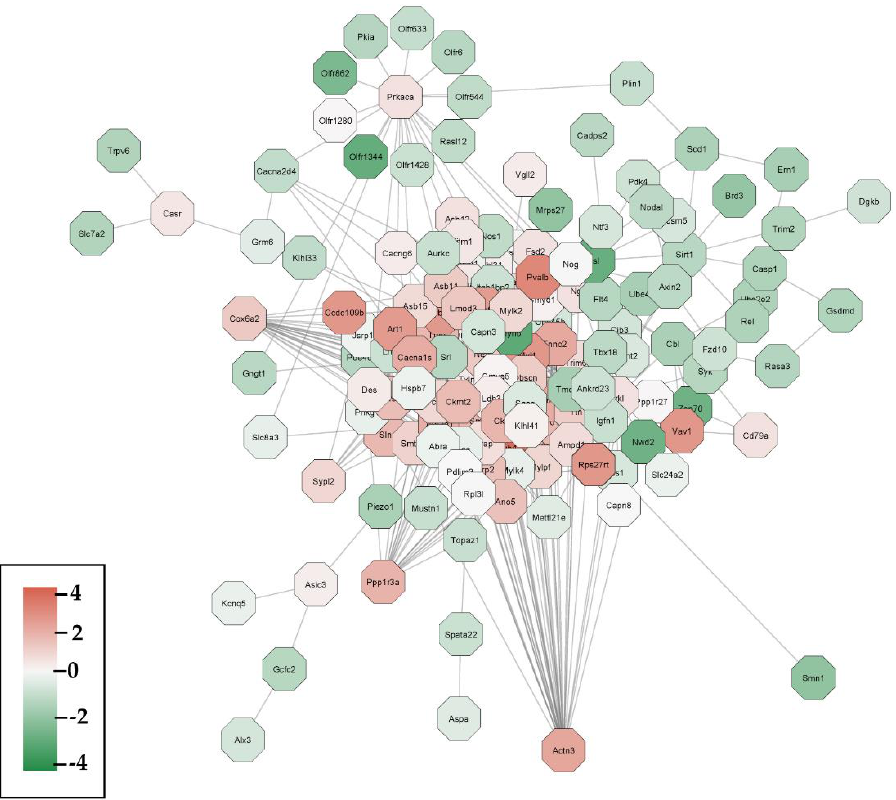
Figure 5. The enlarged regulatory relational network was generated using Cytoscape. The color of the nodes denotes the direction of expression change; red nodes indicate the upregulated genes, while green nodes stand for the down-regulated genes. The color scale measures the expression changes between the control and the combination (BSp + GTPs) treatment group.